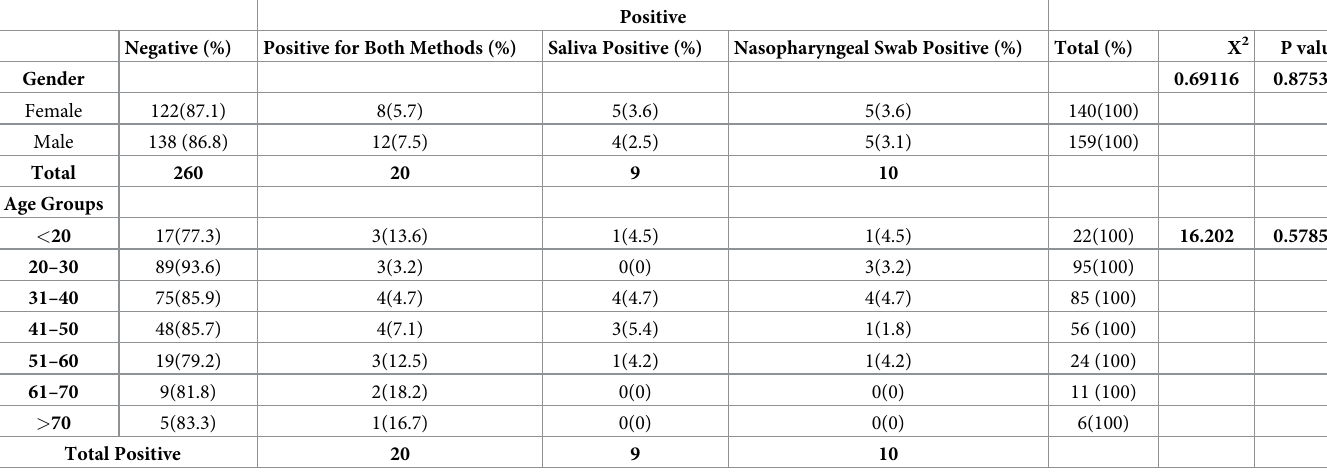
Table 3. SARS-CoV-2 positivity by gender and sample type.